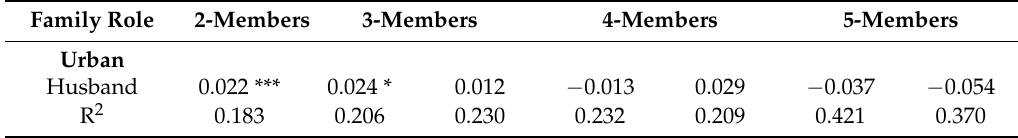
Table A5. International trade effect results (dependent variable: ln individual